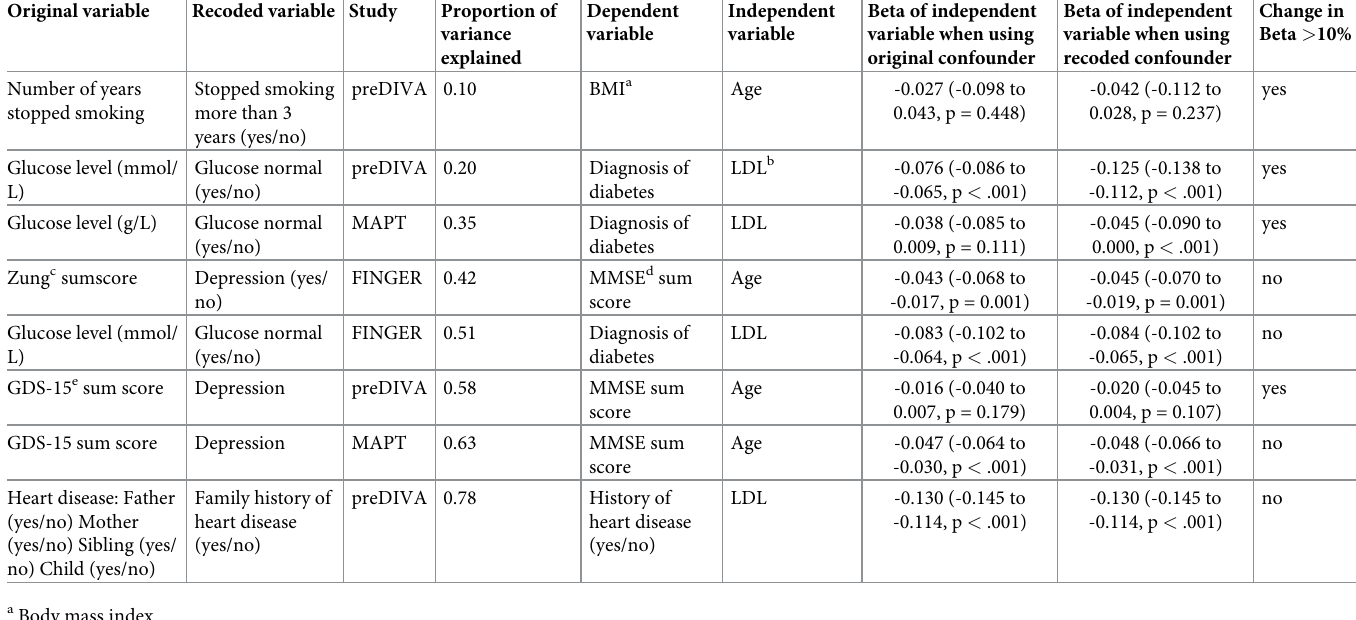
Table 2. Change of the beta coefficient of an association when using the recoded variable as a confounder compared to the original variable for the variables with less than 80% explained variance after recoding to assess the impact of information loss on the validity of